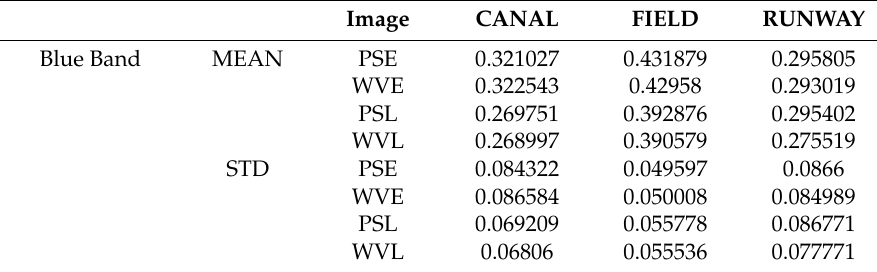
Table 3. Means and stds of Blue band of two image pairs for the three scenarios in Section